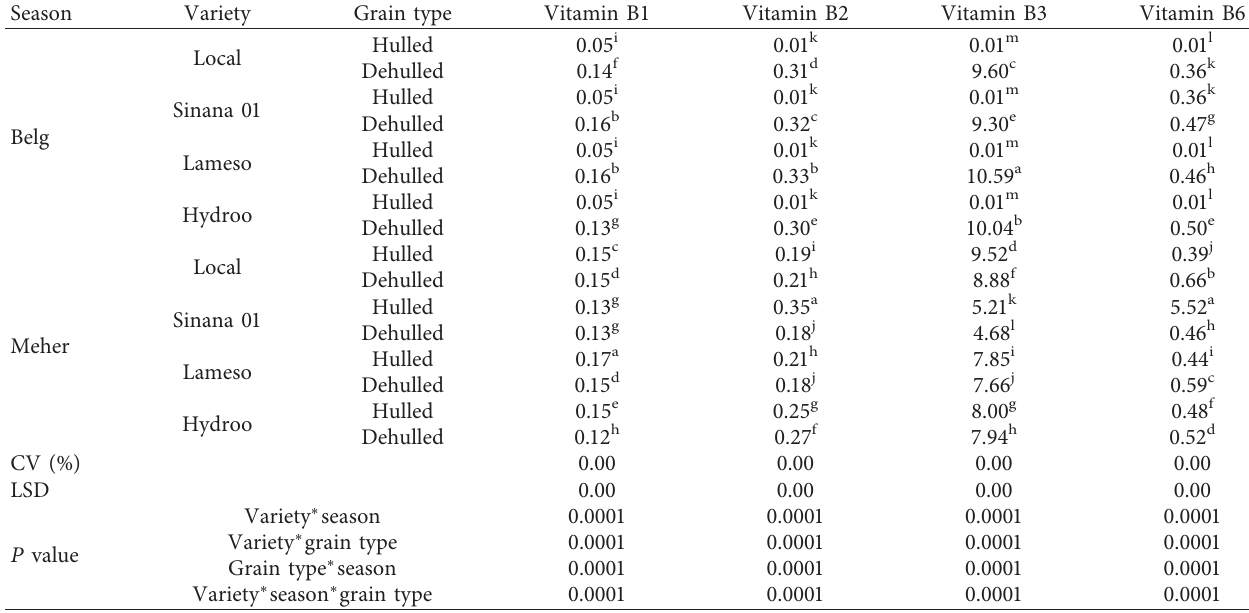
Table 6: Vitamin B (mg/g) complex of emmer wheat as affected by growing season, grain types, and variety. Season